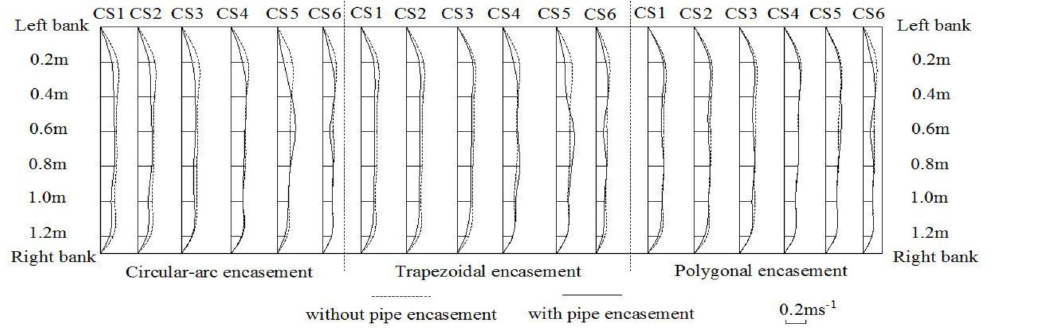
Fig 10. Distributions of flow speeds at CS1-CS6 for an annual discharge.